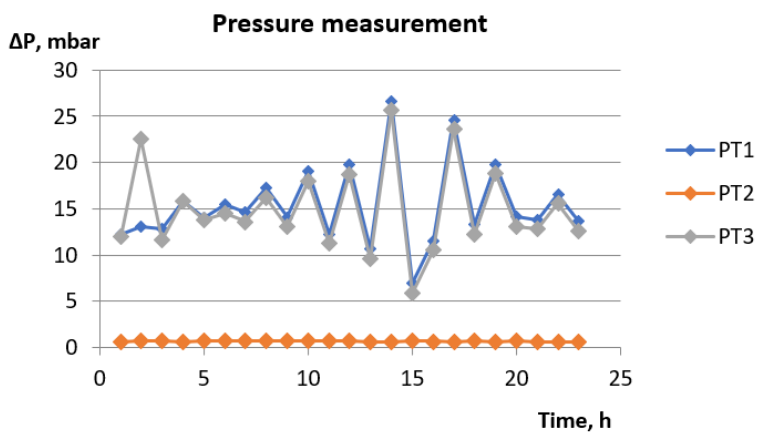
Figure 9. Pressure measurement—measuring points according to the process diagram (Figure 4)— necessary for the production and desulphurization of agricultural biogas produced from a polydisperse substrate [own elaboration]: PT1—measurement inside the fermentor; PT2—measurement before desulfurizer; PT7—measurement after desulphurizer.